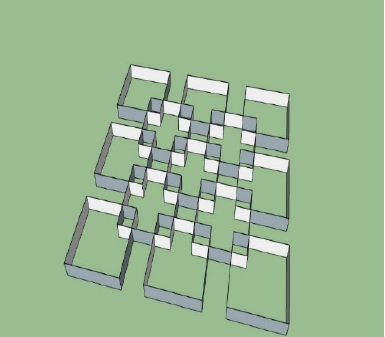
Figure 1. The 3D concrete component model created in Sketch Up.